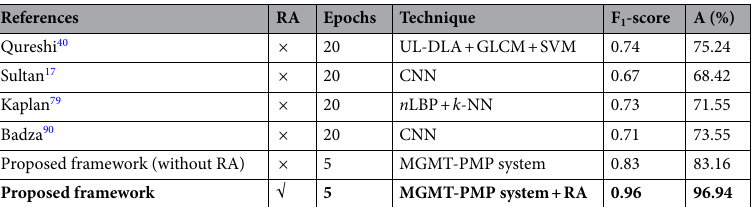
Table 19. Comparison of the proposed framework with other studies for brain tumors using the BraTS-2021 challenge dataset using 80:20 partition for training: testing instances. Significant values are given in